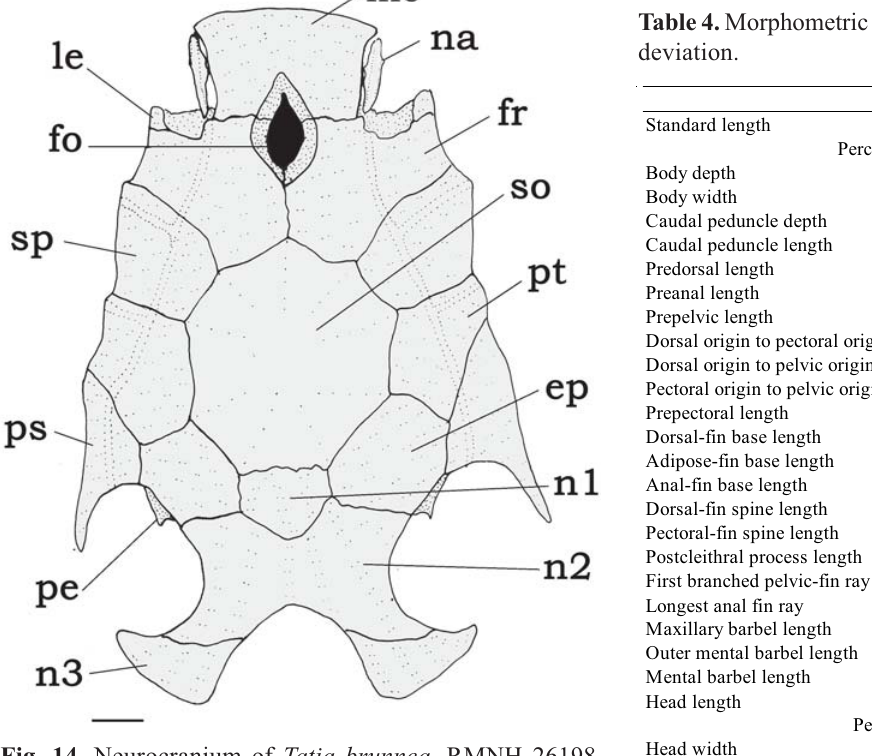
Fig. 14. Neurocranium of Tatia brunnea , RMNH 26198, paratype, 39.1 mm SL. Dorsal view. Abbreviations: ep , epioccipital; fo , single cranial fontanel, fr , frontal; le , lateral ethmoid; me , mesethmoid; na , nasal; n1 , first nuchal plate, n2 ; second nuchal plate; n3 , third nuchal plate; pe , posterior epioccipital process; ps , posttemporal-supracleithrum; pt , pterotic; so , supraoccipital; sp , sphenotic. Scale bar =1.0 mm.